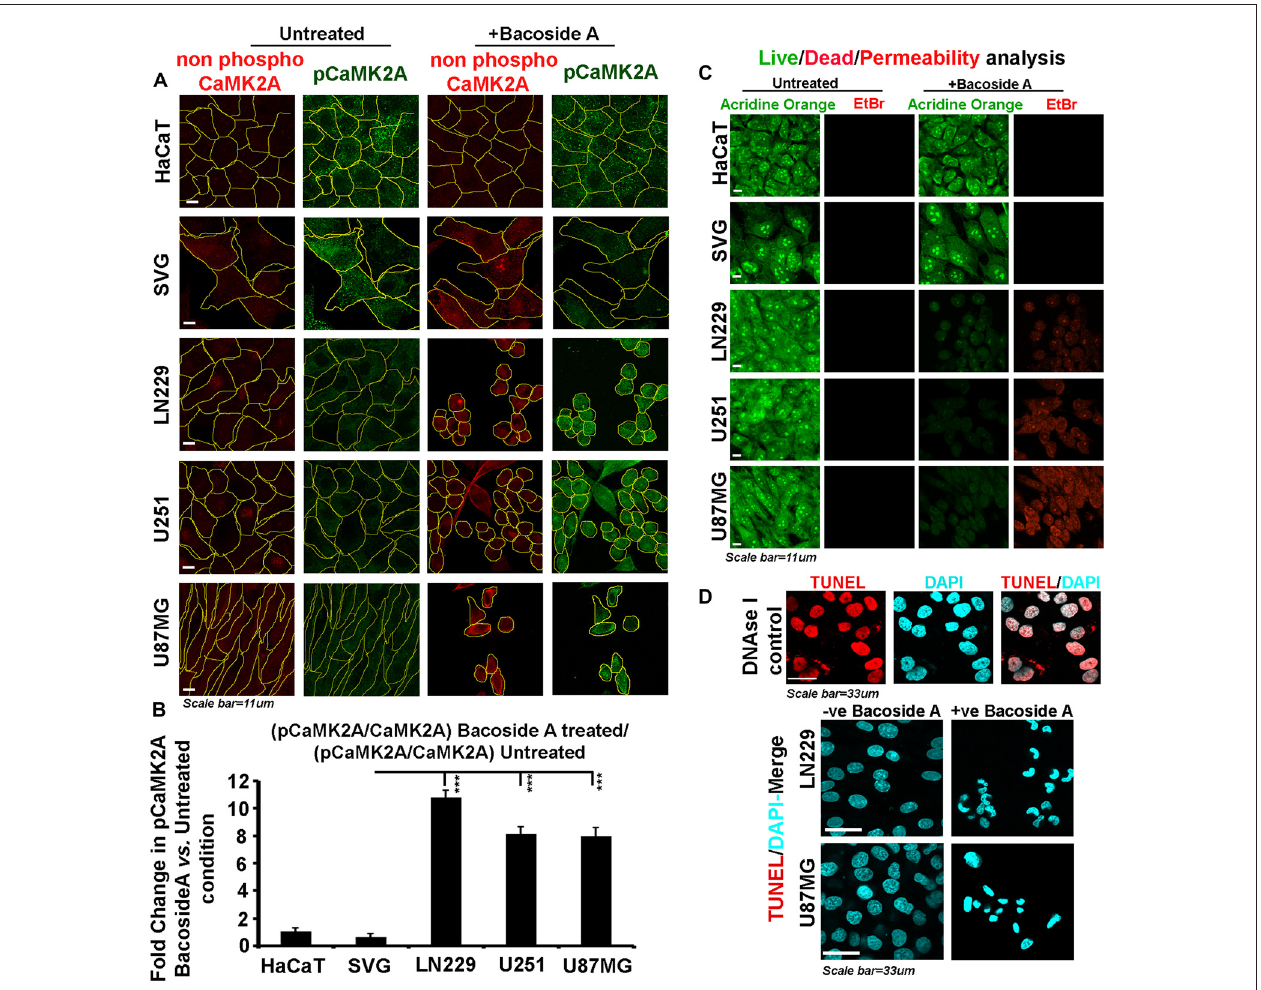
FIGURE 9 | Bacoside A activates extensive T286 phosphorylation of CaMK2A and non-apoptotic glioblastoma cell death. (A) Single cell quantitative image analysis procedure (see John et al., 2017) was employed to measure non-phospho CaMK2A and phospho CAMK2A T286 protein levels in normal human cells: SVG-subventricular zone derived glial cells; HaCaT-epidermal keratinocytes and in various GBM patient derived tumor cell lines: U87MG, U251 and LN229 upon Bacoside A (8 µ g/ml) treatment for 24 h. (B) The proportion of phosphorylated CaMK2A determined by normalizing average signal of pCaMK2A-T286 to average signal from non-phospho CaMK2A in BM treated cells vs. the ratio in the normal cells, showed higher levels of pCaMK2A in treated tumor cells but not the normal control cell lines. Please note that just “CaMK2A” in the formula refers to predominantly the non-phosphorylated pool. The analysis is representative of three independent experiments and in each experiment protein signal was quantified from over 200 cells in five random fields. (C) Acridine orange (green, live cell marker probe)/EtBr (red, damaged and dead cell marker dye) based cytotoxicity and viability analysis over 24 h post Bacoside A treatment at 8 µ g/ml showed specific cytotoxic effects on LN229/U87MG/U251 glioblastoma cell lines vs. the normal cells. (D) LN229 and U87MG GC treated with 8 µ g/ml of Bacoside A for 48 h were negative for TUNEL staining (indicator assay for apoptotic cell death). ∗∗∗ p < 0.001. Error bar = SD The analysis is representative of three independent